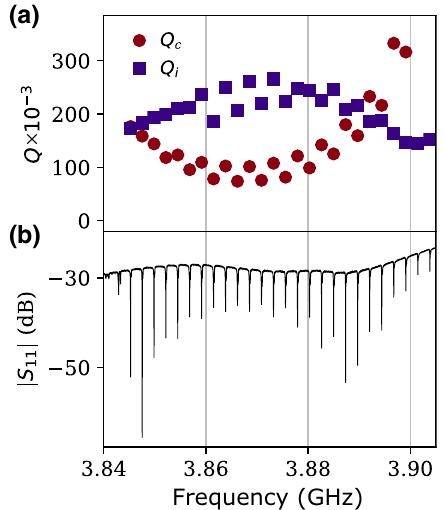
FIG. 2. Resonator characterization. (a) External and internal quality factors for each mode in the comb. Modes near the cen- ter of the 26-mode comb are overcoupled ( Q c < Q i ) and have internal quality factors Q i > 10 5 at high power. (b) Reflection coefficient measured from the IDT with a vector network ana- lyzer. The alternating even and odd mode pattern as well as the frequency dependence of the IDT response and mirror stopband are visible in the magnitude of resonance